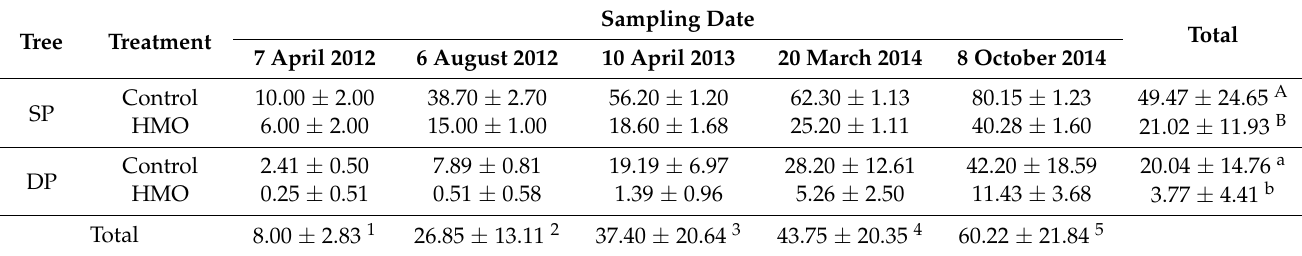
Table 2. Effect of horticultural mineral oil (HMO) on percentage of HLB-infected trees in a citrus orchard. Tree